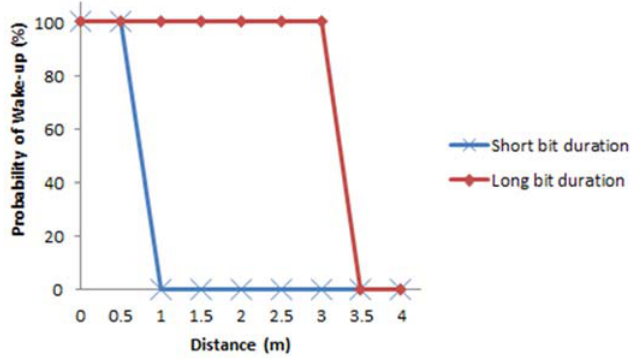
Figure 16. Probability of wake-up vs. distance for short and long bit duration, under interference from fluorescent light with correlator setting ON.